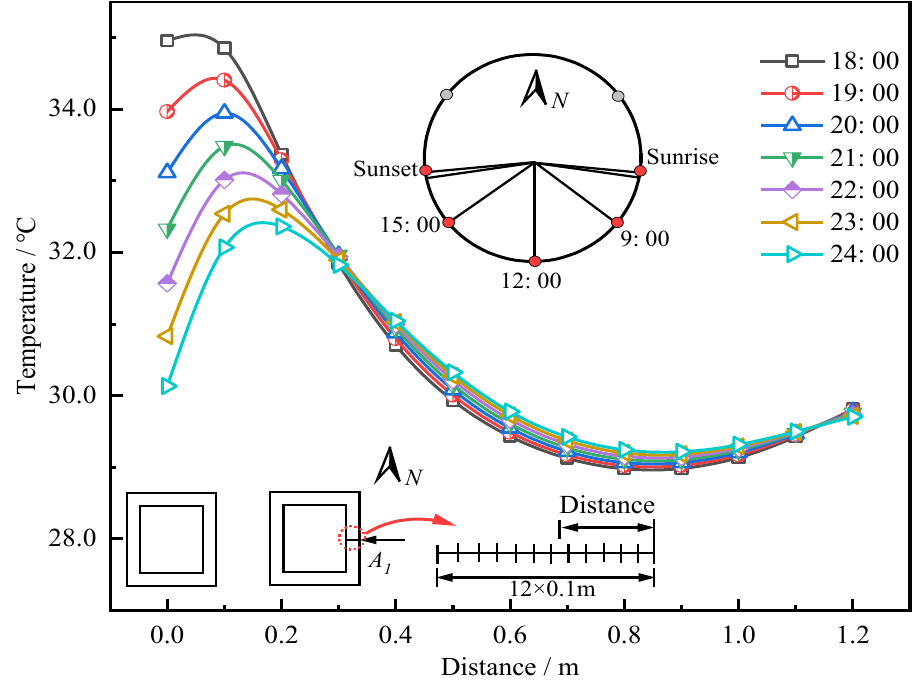
Figure 23. The temperature variation curve at night in the thickness direction of the east tower wall at a 125 m height.